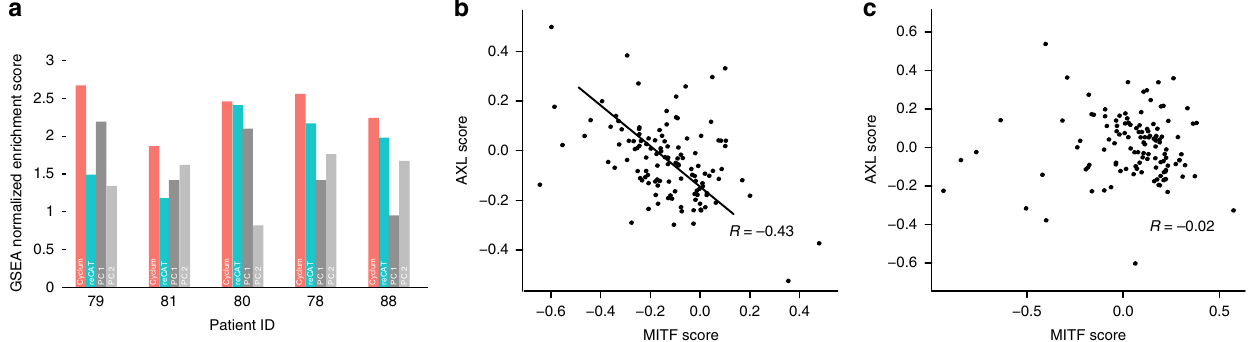
Fig. 4 Cyclum results on the melanoma data. a GSEA NES scores were obtained based on pseudo-times inferred by Cyclum, reCAT, and principal component 1 and 2. b The correlation between the MITF score and the AXL score for sample Mel78, based on Cyclum corrected expression data. c The correlation based on the uncorrected expression data. The AXL and MITF scores were calculated based on the average expression levels of the reported genes in AXL and the MITF program 31 . The lines in ( b ) were drawn manually for visual reference. The R values are the Pearson correlation coef fi cients. For all subpanels, source data are provided as a Source Data